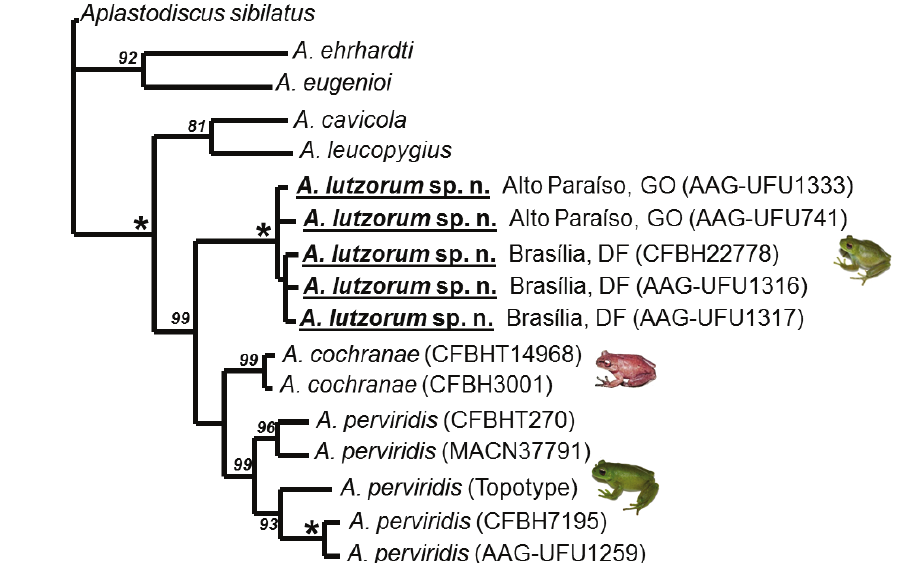
Figure 7. One of the four most parsimonious trees recovered. Asterisks indicate 100% Parsimony Jackknife ab- solute frequency; only values above 75% are shown. See Suppl. material 2 for details and complete locality